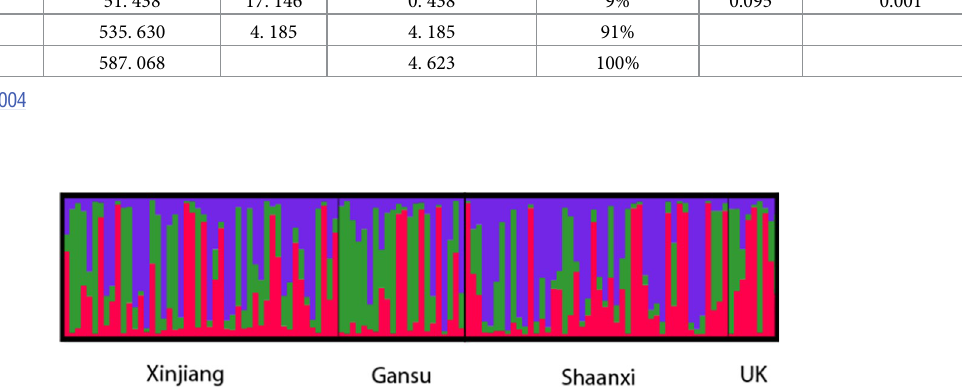
Table 4. Analysis of molecular variance (AMOVA) of SSR data for Venturia inaequalis isolates grouped by geographic origin (Shaanxi, Gansu, Xinjiang and the U. K.). Variation source